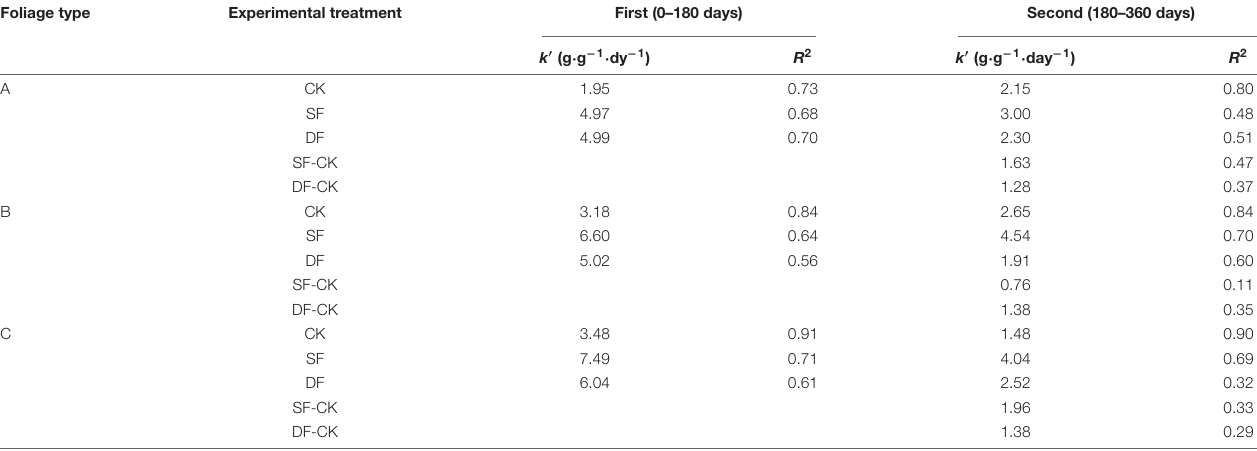
TABLE 3 | Changes in decomposition rate ( k (cid:48) , g · g − 1 · day − 1 ) of leaves of Taxodium distichum (A), Salix matsudana (B), and their mixtures (C) under different experimental treatments. Foliage